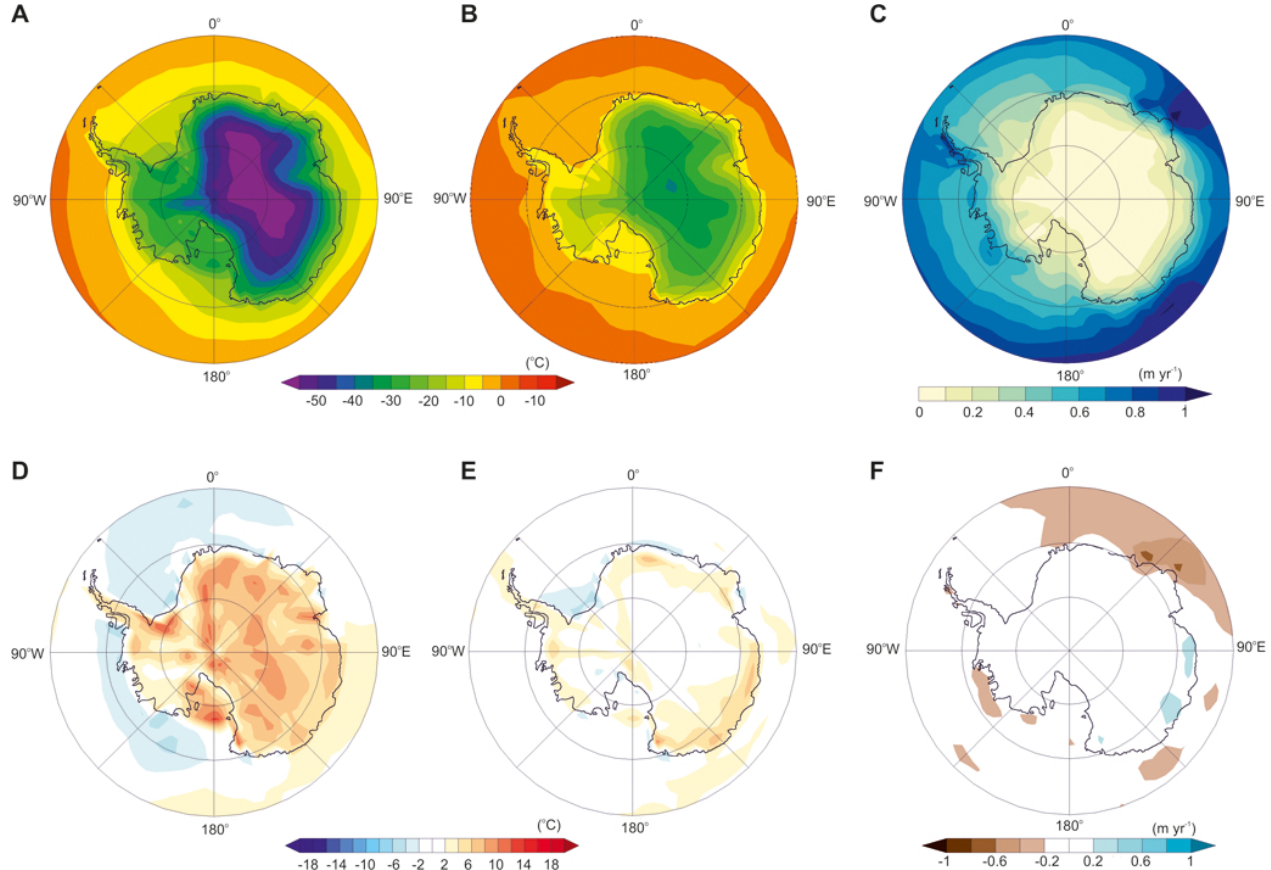
Fig. 2. Control phase driving climatologies. HadAM3 modelled (a) mean annual and (b) summer (January) surface air temperature ( ◦ C), (c) mean annual precipitation rate (myr − 1 ) and the differences between NCEP reanalysis data and HadAM3 (NCEP-HadAM3) for (d) annual mean and (e) summer surface air temperature ( ◦ C) and (f) precipitation (myr − 1 ) over Antarctica. Note that NCEP reanalysis data were interpolated to the HadAM3 GCM grid before calculating the